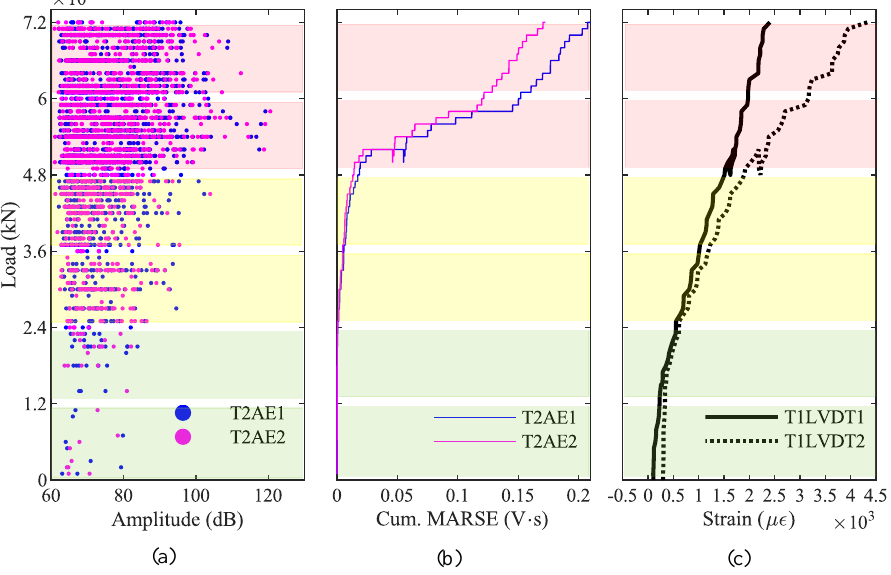
Figure 18. Results from AE and LVDT sensors during phase P4: ( a ) amplitude from girder T2; ( b ) cumulative signal strength from girder T2; ( c ) longitudinal strain at the bottom of girder T1.